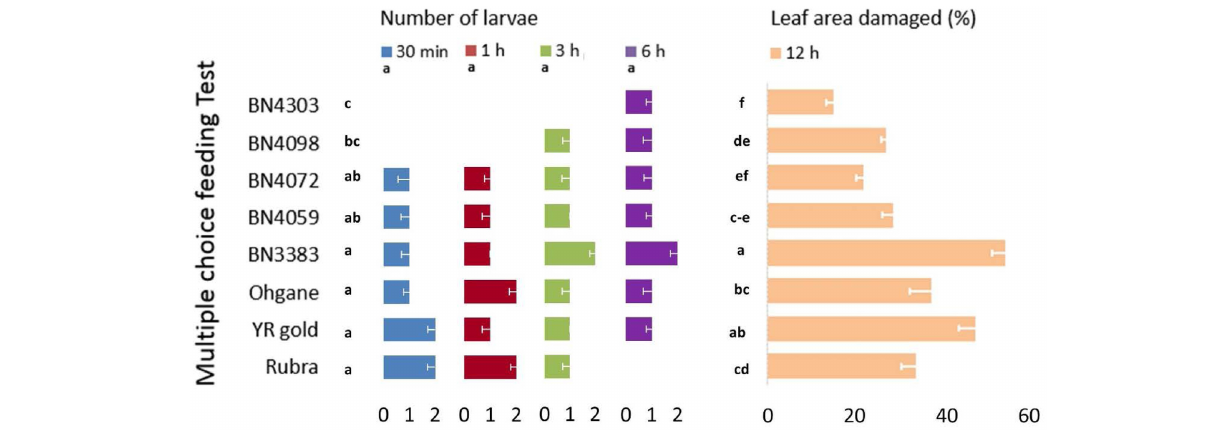
Table S1. Normality and deviance of data, degrees of freedom, test statistic, and p -value of statistical significance of different traits are given in Supplementary Table